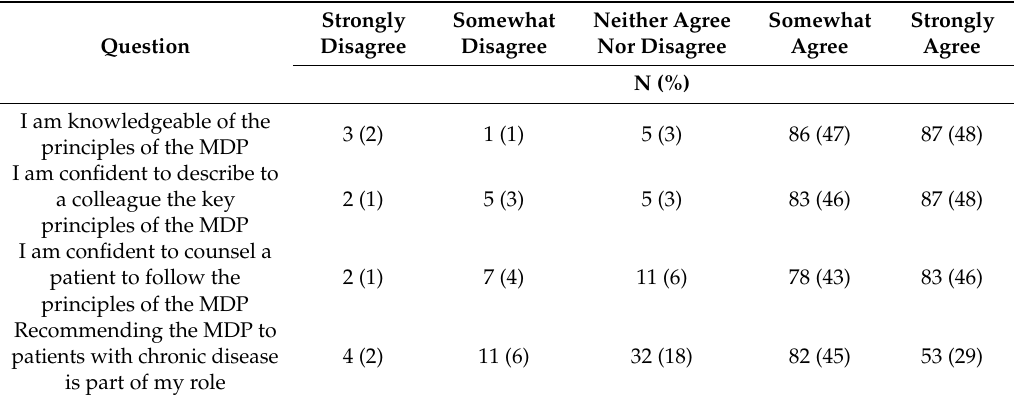
Figure 1. Level of agreement regarding evidence to support the Mediterranean dietary pattern across chronic disease populations. CVD, cardiovascular disease; T2D, type 2 diabetes; NAFLD, non-alcoholic fatty liver disease; SOT, solid organ transplant. Table 2. Participants’ perceived knowledge, confidence and role in relation to counselling on the MDP ( n =